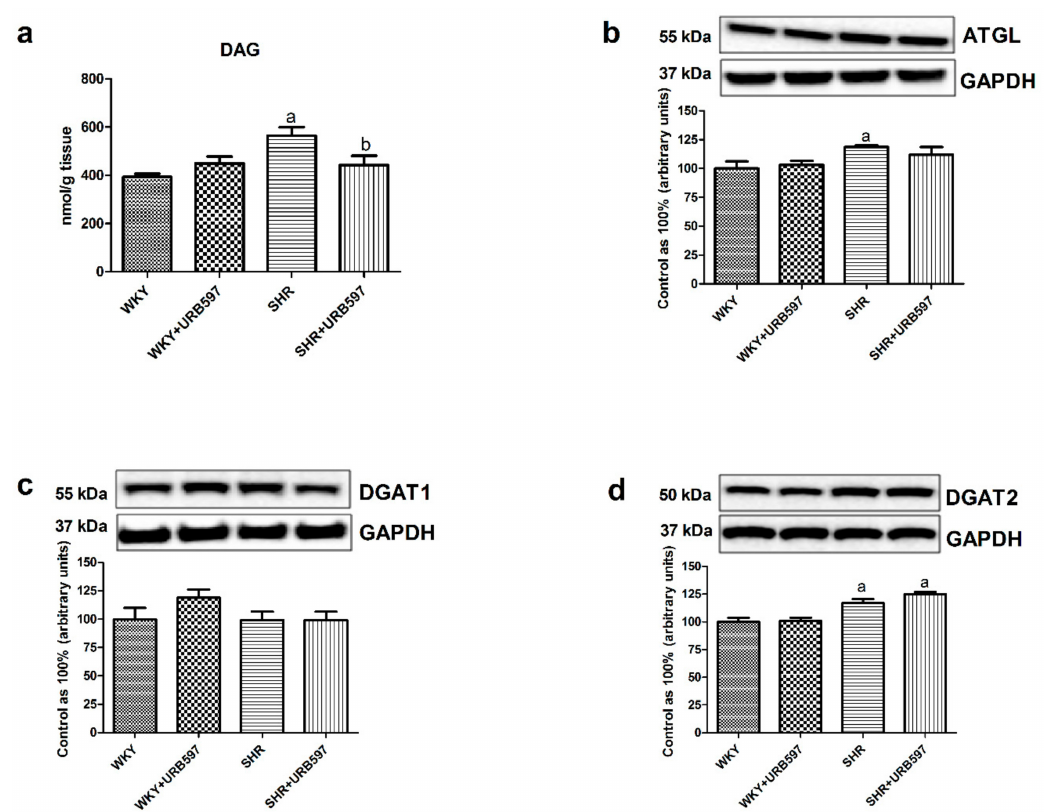
Figure 2. The e ff ect of chronic URB597 treatment on the left ventricle content of diacylglycerols (DAG) ( a ) as well as total expression of adipose triglyceride lipase—ATGL ( b ), diacylglycerol acyltransferase 1—DGAT1 ( c ) and diacylglycerol acyltransferase 2—DGAT2 ( d ) in the control Wistar Kyoto rats